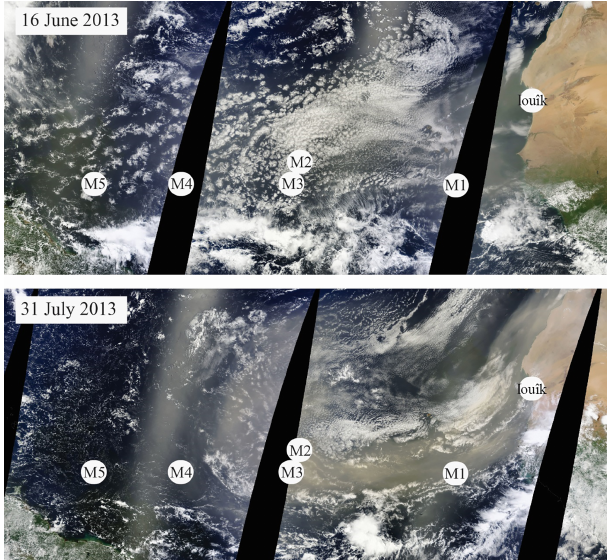
Figure 9. Satellite images (from NASA Worldview, MODIS Terra satellite) showing dust outbreaks propagating westwards from the African coast across the Atlantic Ocean, the location of the land- based dust samplers at Iouîk and the five ocean moorings M1 through